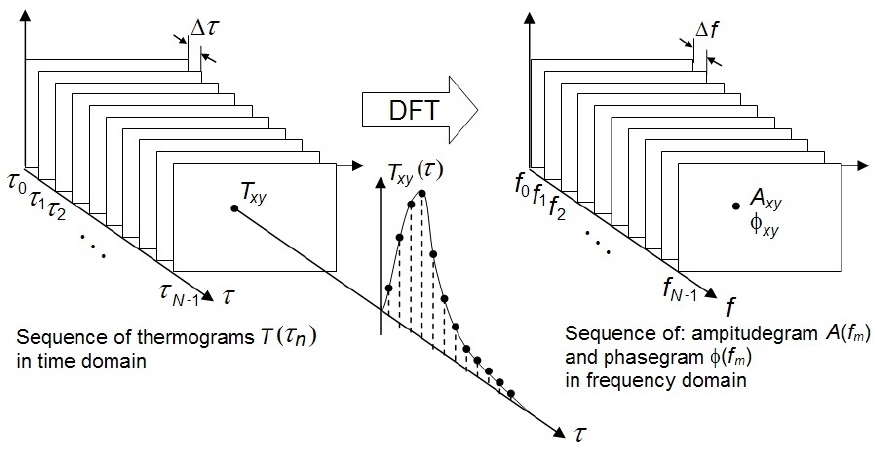
Figure 5. Sequence of images in the time and frequency domains.